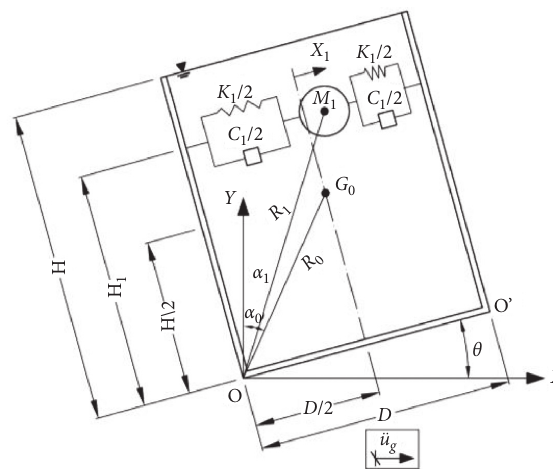
Figure 1: Analytical model for the rocking behavior of ground- supported tanks presented by Taniguchi